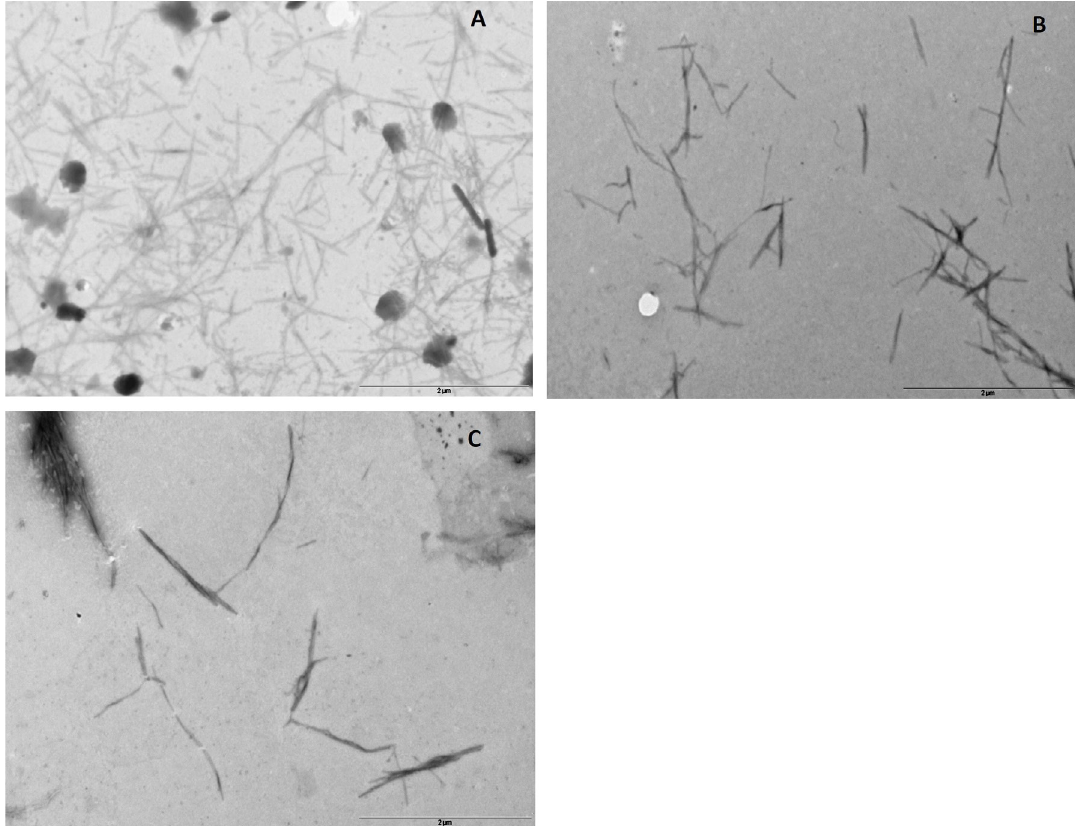
Figure 4. TEM images of pristine nanocellulose NCB (A), succinated (NCB-suc, B), and NCB-lip for conjugated with lipase